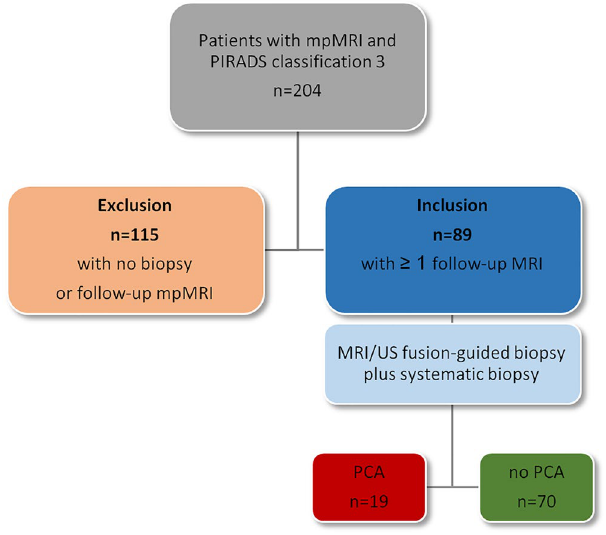
Figure 1. Flowchart of included patient. mpMRI: multiparametric magnetic resonance imaging; PI-RADS: Prostate Imaging Reporting and Data System; PCA: prostate